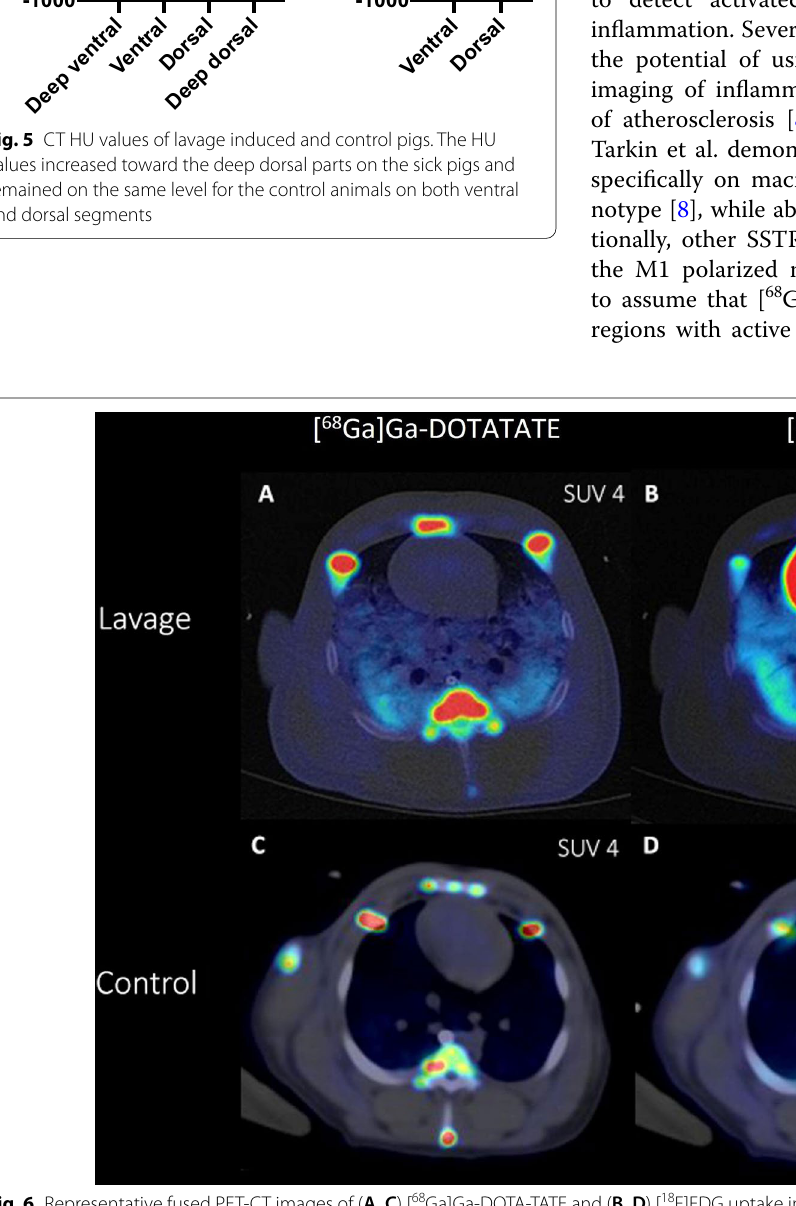
Fig. 6 Representative fused PET‑CT images of ( A, C ) [ 68 Ga]Ga‑DOTA‑TATE and ( B, D ) [ 18 F]FDG uptake in lavage ( A, B ) and control ( C , D ) pigs. Signal quantification is presented as summary of 30 min‑60 min p.i. in SUV mean